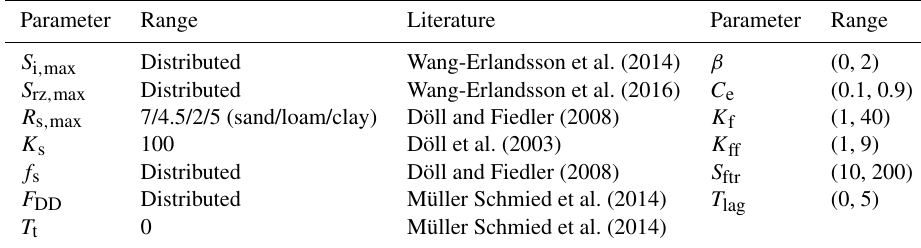
Table 2. Parameter ranges of the WAYS